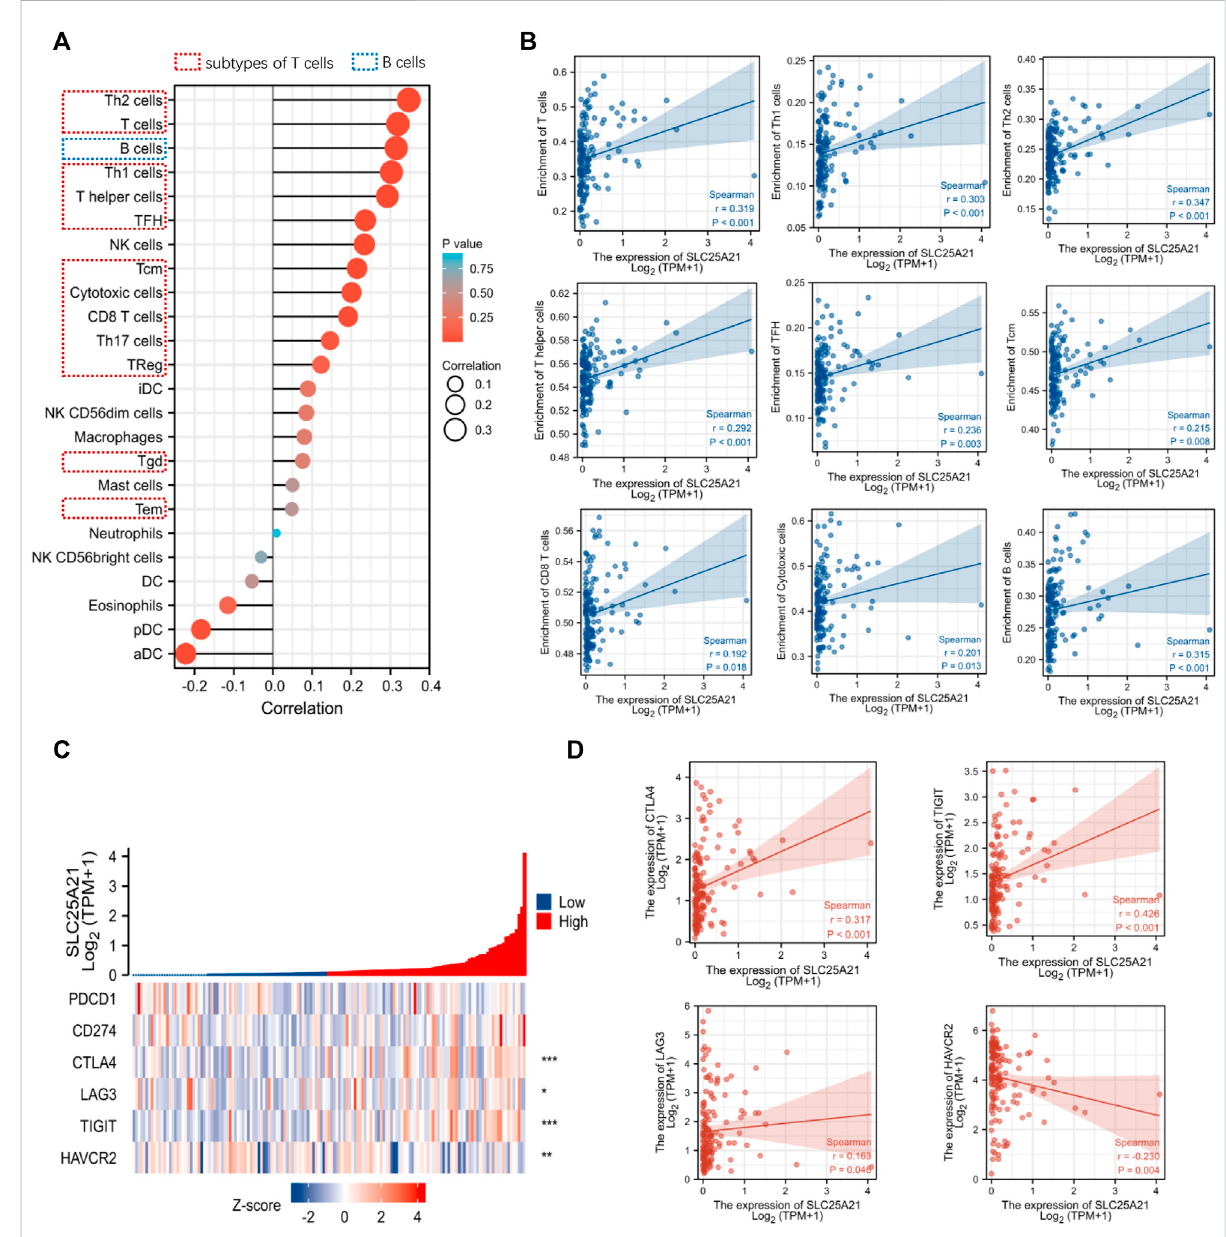
FIGURE 6 Correlation analysis between the level of SLC25A21 expression and immune cell in fi ltration or immune checkpoint molecules. (A) The relative contents of 24 kinds of immune cells in AML. (B) Spearman ’ s correlations were used to quantify the correlation of SLC25A21 expression with the numberofin fi ltratinglevel BcellsandsubtypesofT-cells. (C) TheassociationofSLC25A21with fi veimmunecheckpointmolecules(PDCD1, CD274, CTLA-4, LAG-3, TIGIT, and HAVCR2). (D) Spearman ’ s correlation was used to quantify the correlation of SLC25A21 expression with immune checkpoint molecules (r is Spearman ’ s correlation coef fi